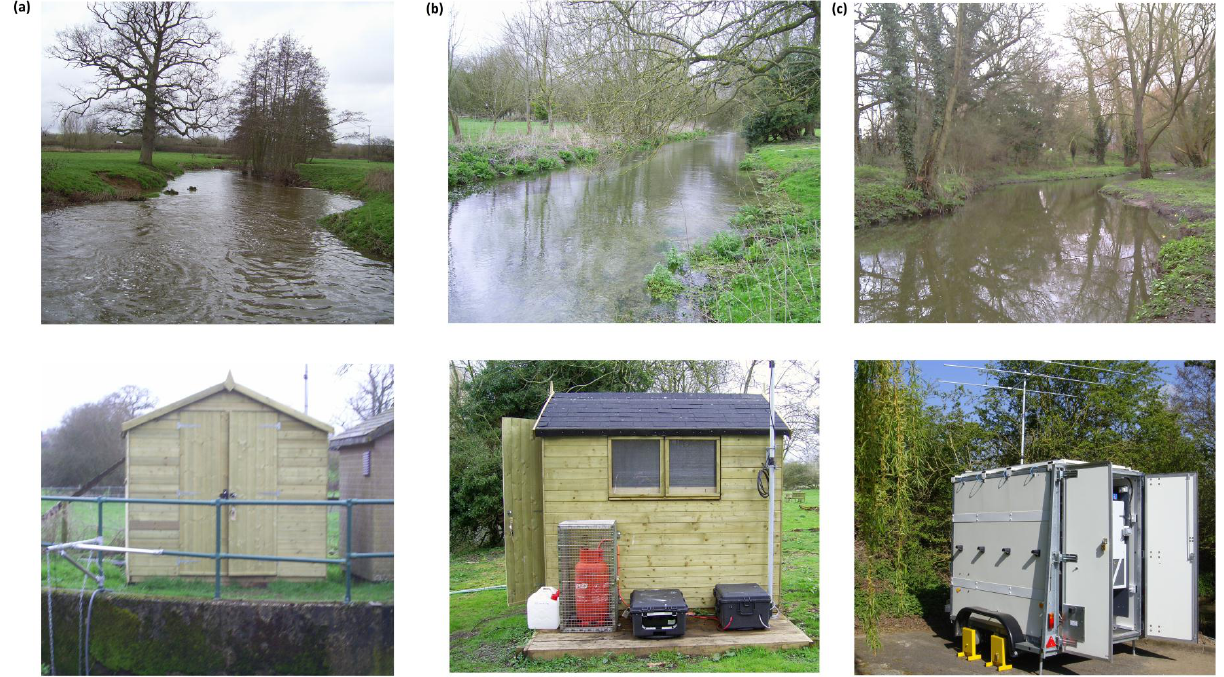
Fig. 3. Photographs of the river monitoring stations. River systems (top row – taken in March 2010): (a) River Enborne at Brimpton (Great Britain National Grid Reference, SU56776477), (b) River Kennet at Clatford (SU16016885) and (c) The Cut at Bracknell (SU85837050). Monitoring stations (bottom row – taken in April 2010): (a) River Enborne at Brimpton (SU56776477), (b) River Kennet at Clatford (SU16016885) and (c) The Cut at Bray